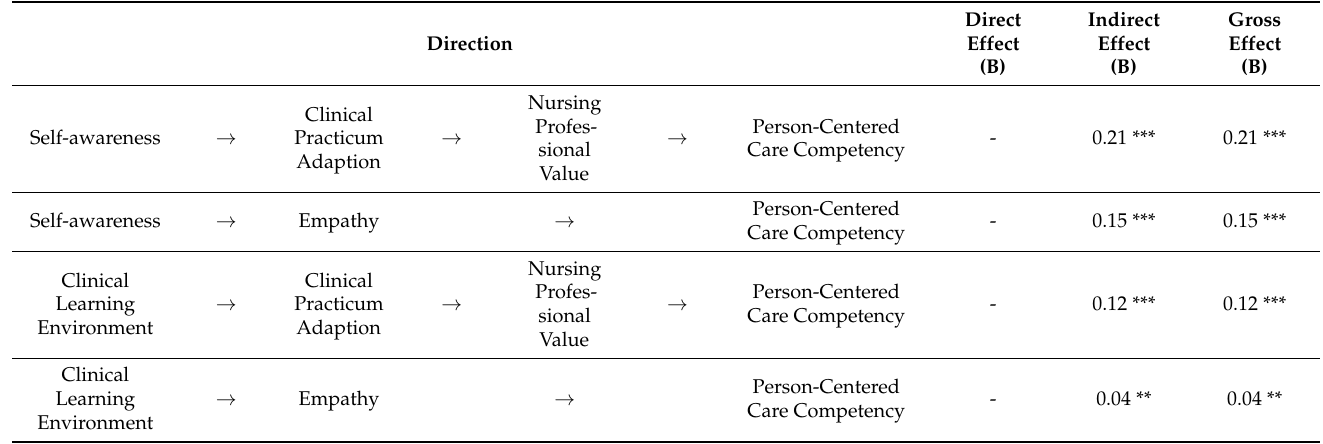
Table 7. Mediating effect analysis by phantom